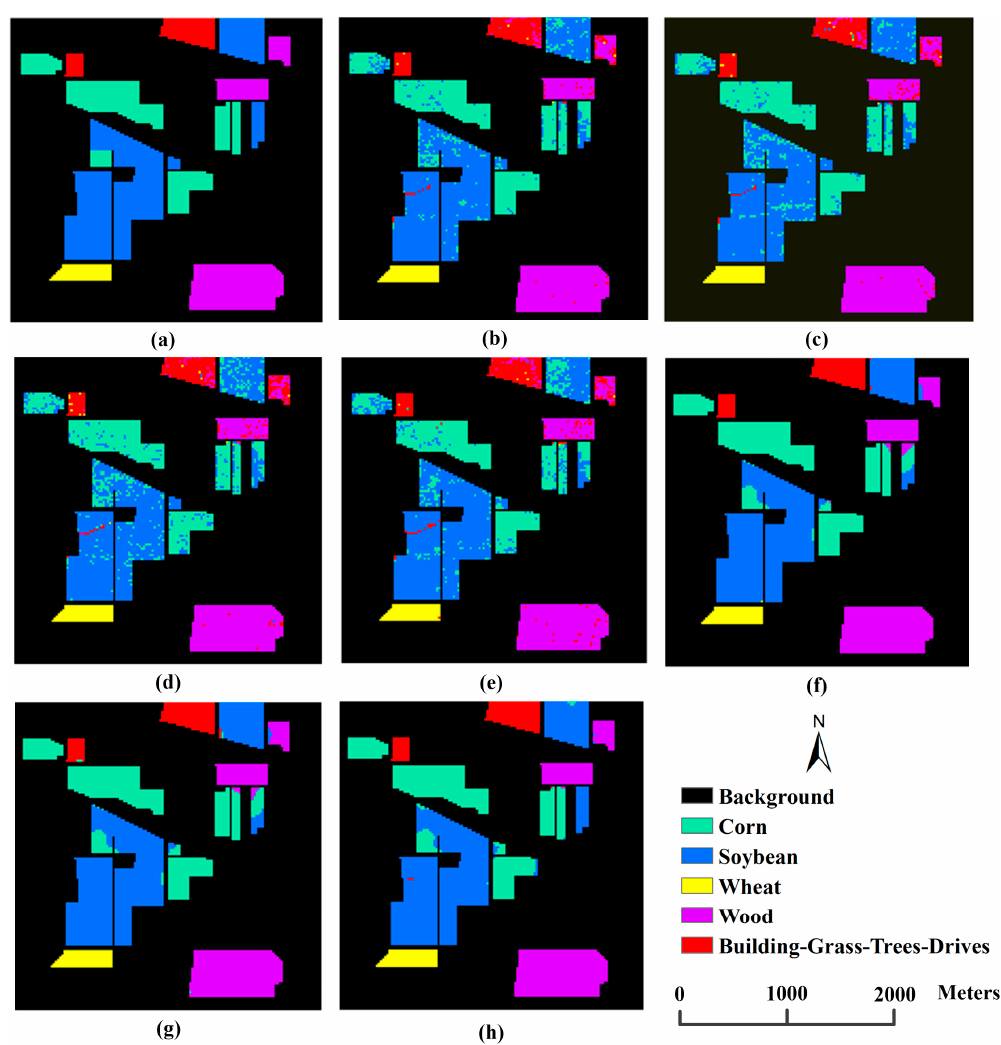
Figure 6. Classification maps of the Indian Pines data set. ( a ) Reference data; ( b ) ClassPair_ScatterMatrix; ( c ) AllClass_ScatterMatrix; ( d ) JM; ( e ) JMI; ( f ) Gabor; ( g ) SpeSpaDF; ( h ) SpeSpaVS_ClassPair_ScatterMatrix.